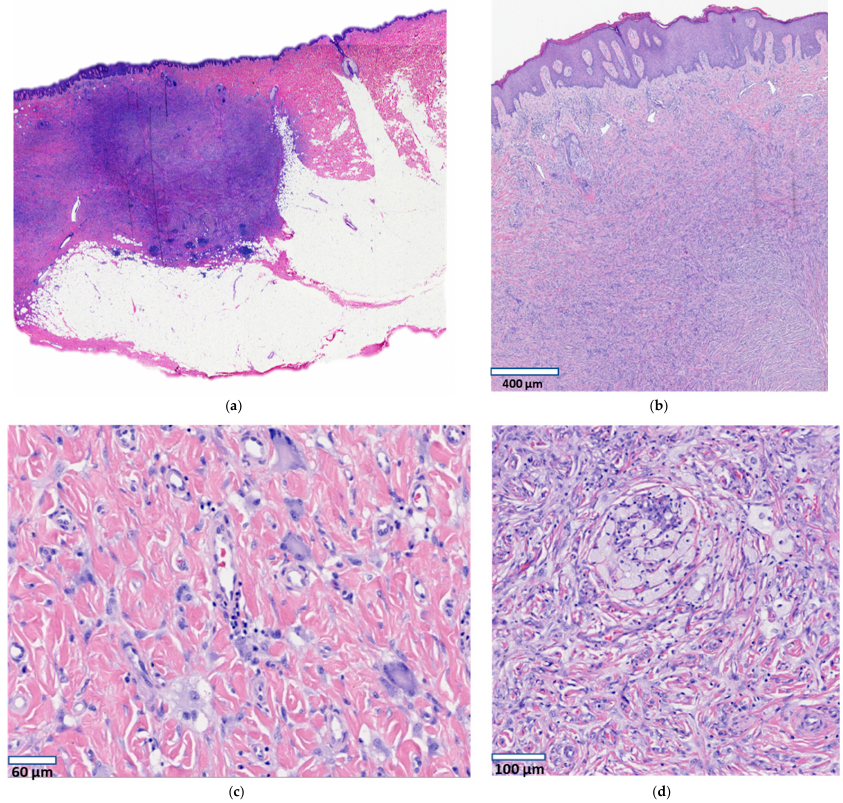
Figure 1. A plaque with irregular brown pigmentation.